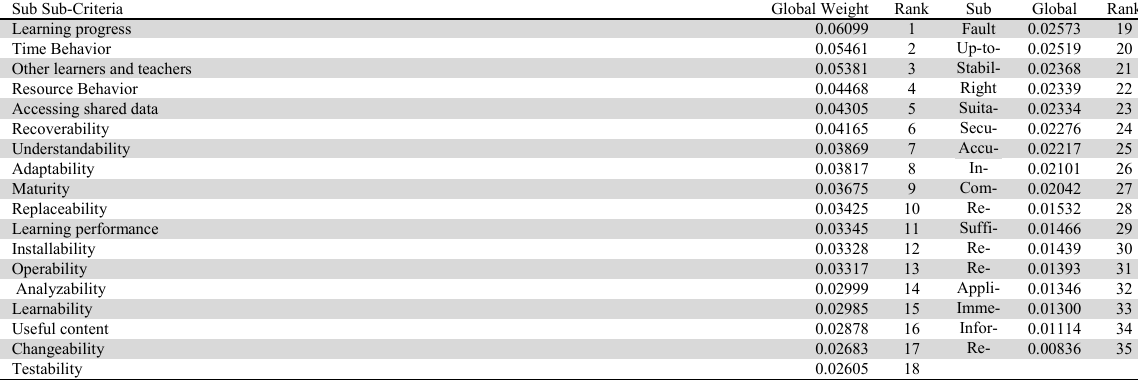
Rankings of sub sub-criteria weights Sub Sub-Criteria Global